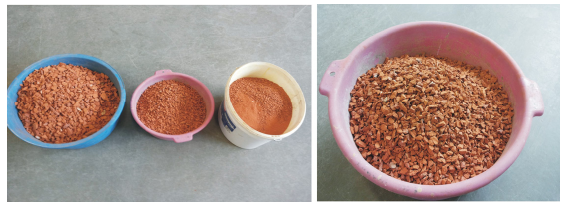
Figure 2. Sorted crushed brick and related 4/8 fraction.